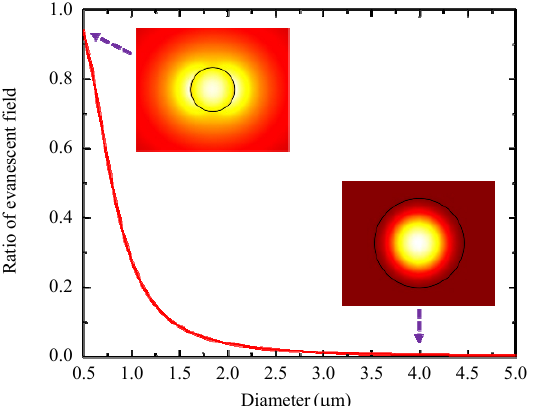
Fig. 2 Ratio of evanescent field penetrating into surrounding air to the field propagating in the fiber as a function of the fiber diameter at a wavelength of 1550 nm. The upper and lower insets are the power flow distributions of 0.5- μ m-diameter and 4- μ m-diameter silica microfibers, respectively. Dimensions of the insets are not to scale.